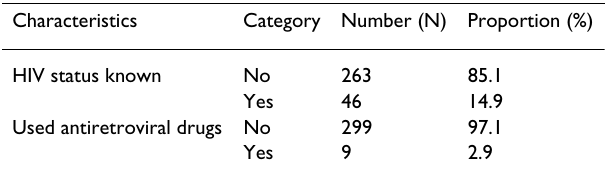
Table 2: Characteristics of HIV seropositive pregnant women